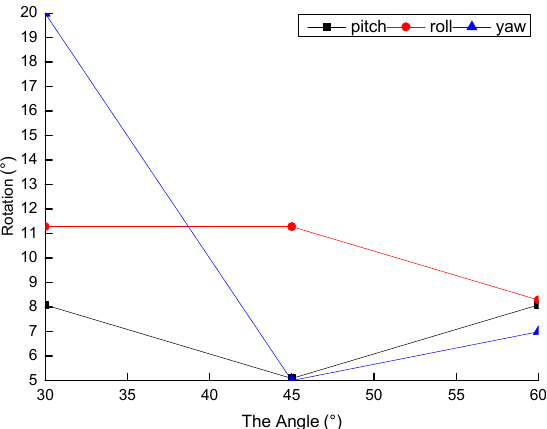
Figure 17. Stability influence of mooring angle for the device.